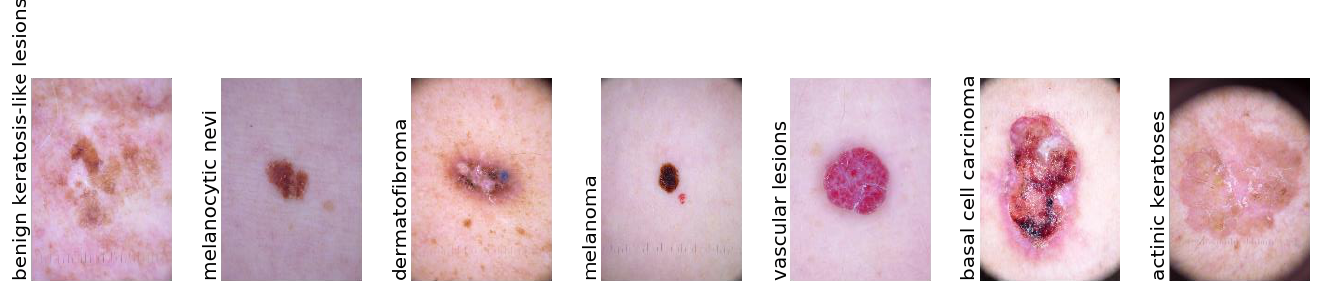
Figure 2. A visual example of a selection of region-of -interests (ROIs) from PSLs lesions after automatically selecting from centroid position.